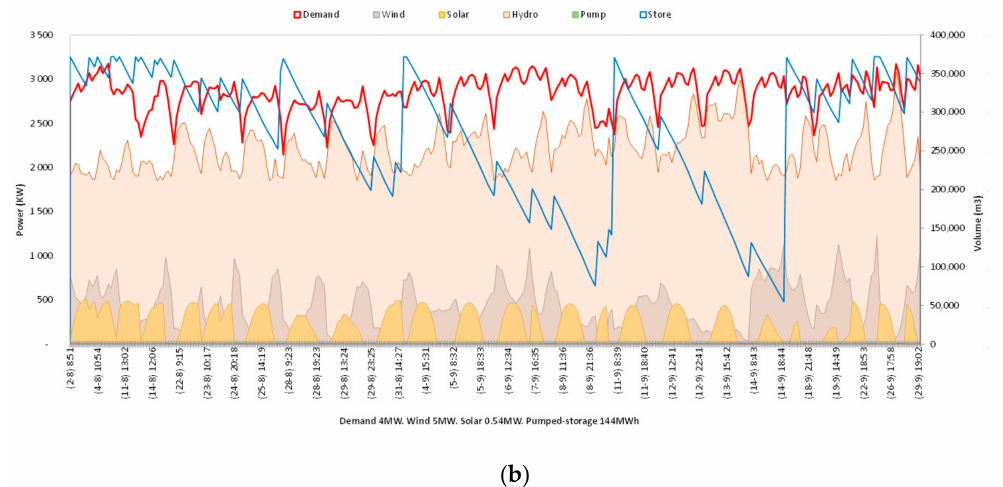
Figure 11. Total amount of hydropower when using wind energy with 5 MW, between February and March ( a ) and August-September ( b